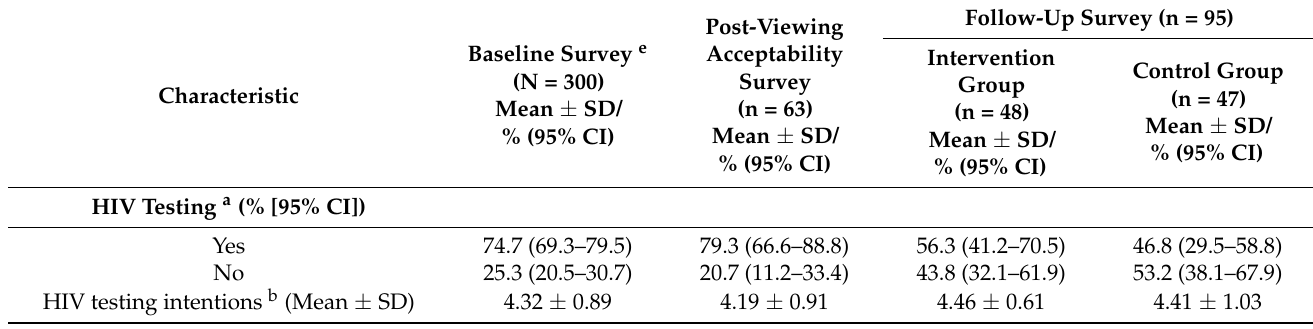
Table 4. HIV testing behaviors and intentions, knowledge of HIV transmission dynamics and knowledge of HIV-related rights by group and time